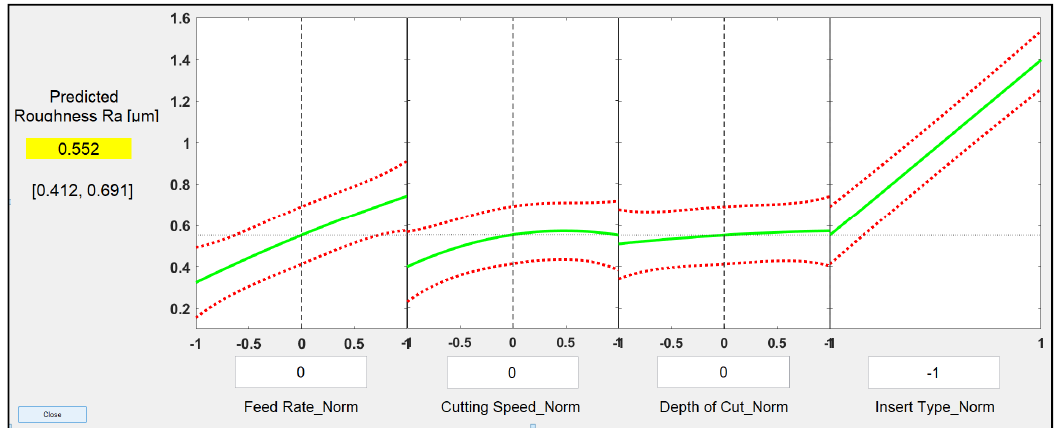
Figure 11. Prediction slice plots created using the developed process regression model for roughness of AISI 4340 specimens machined by both types of inserts, wiper and conventional. Table 3. Turning validation results of the proposed regression model: measured vs. predicted Ra.